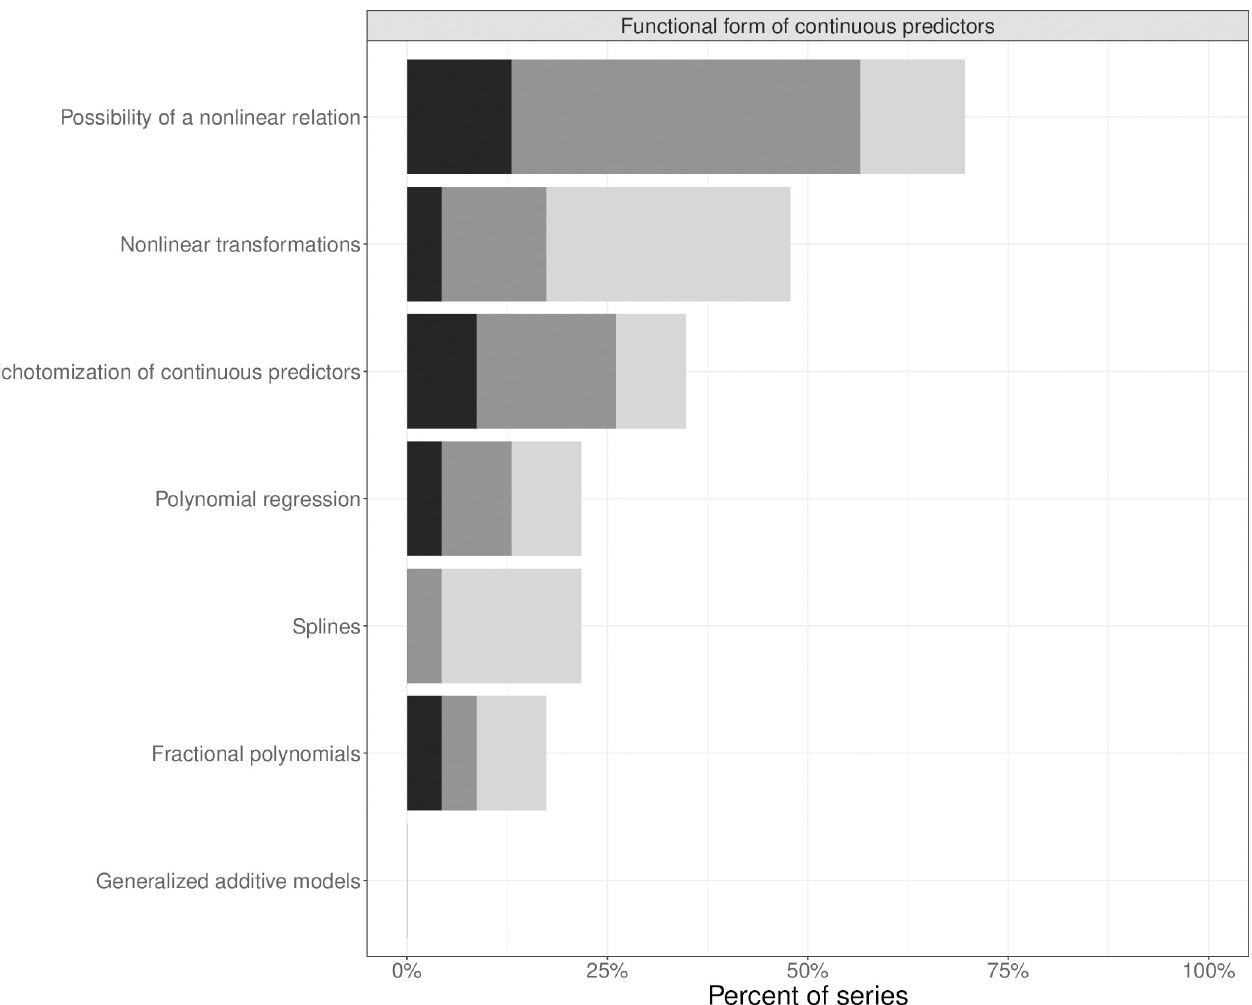
Fig 4. Extent of explanation of aspects of functional forms of continuous predictors in statistical series: One sentence only (light grey), more than one sentence to one paragraph (grey) and more than one paragraph (black).